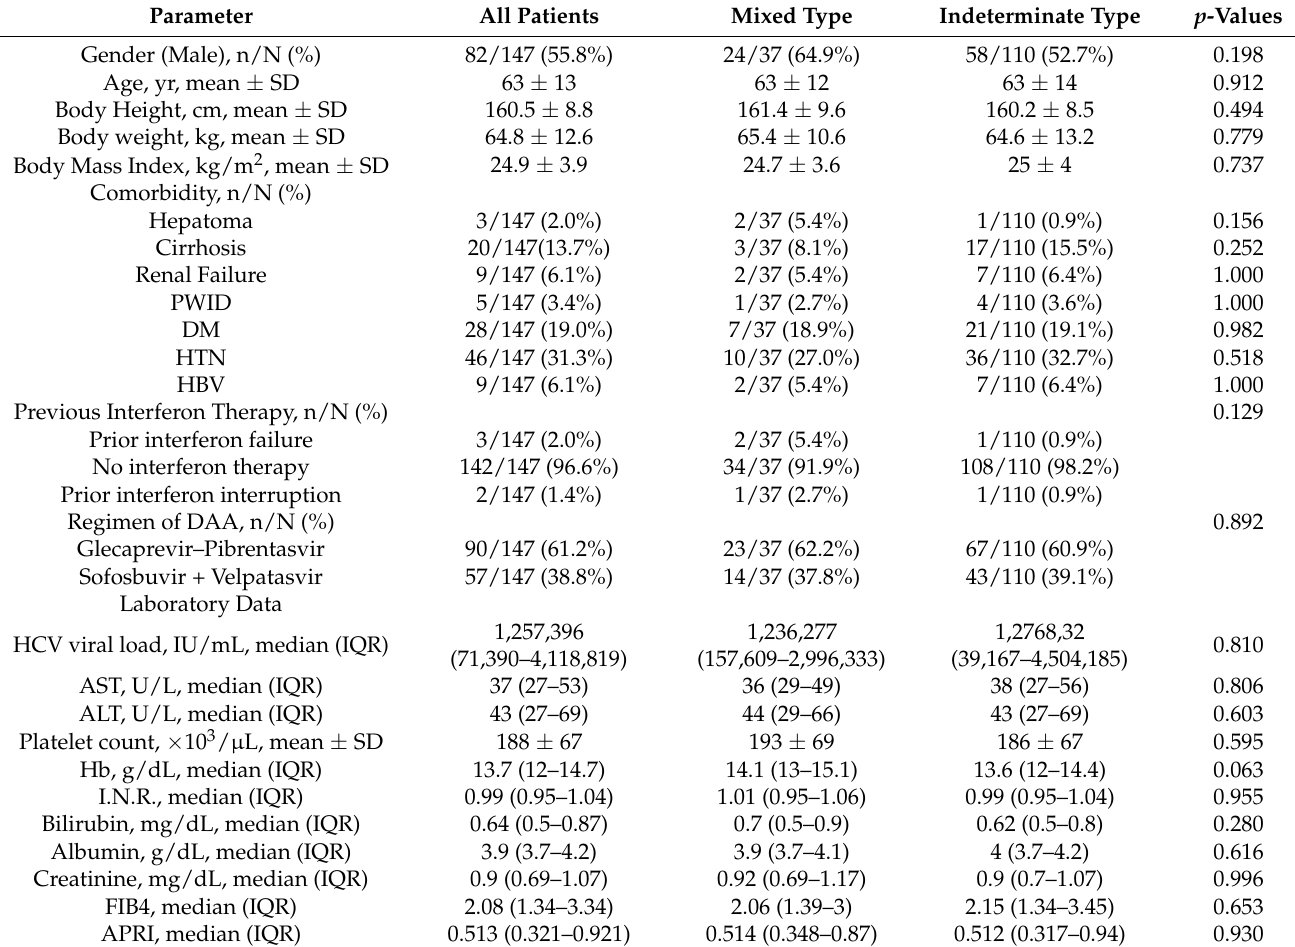
Table 1. Patient characteristics.